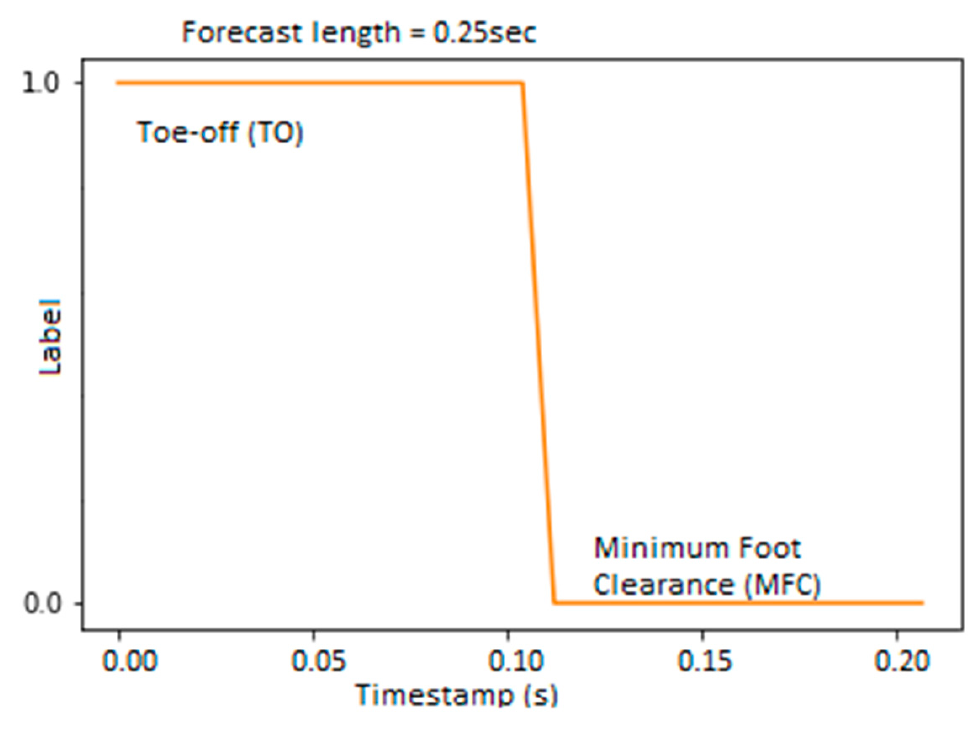
Figure 4. Performance comparison of Huber loss, MSE loss, and MAE loss functions on the training data with 50 past observations at different window lengths.